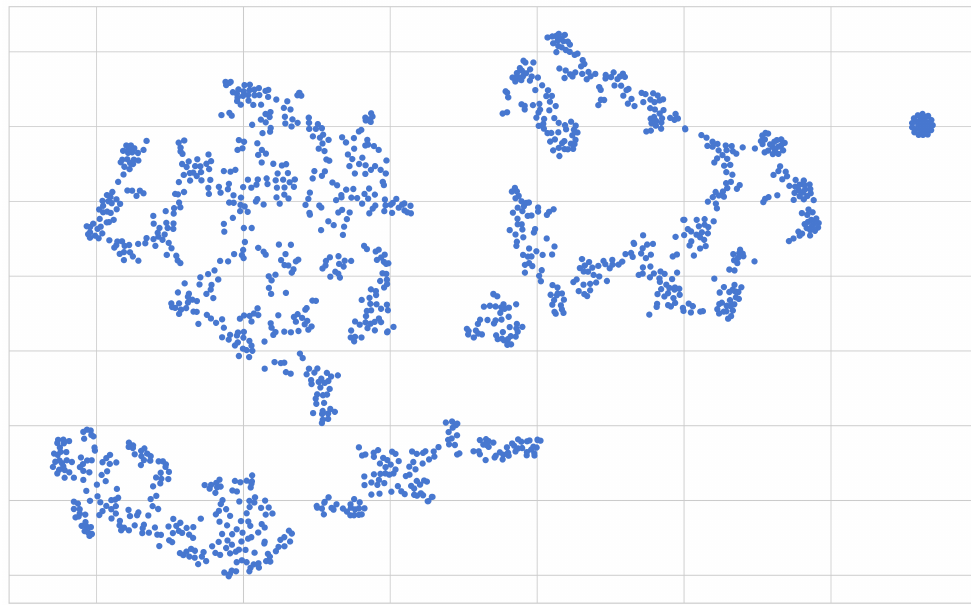
Figure 15. The output of performing the UMAP algorithm on the 20-dimensional UCID dataset. Each point in this figure represents a single sample (or day) within our dataset mapped onto a 2-dimensional